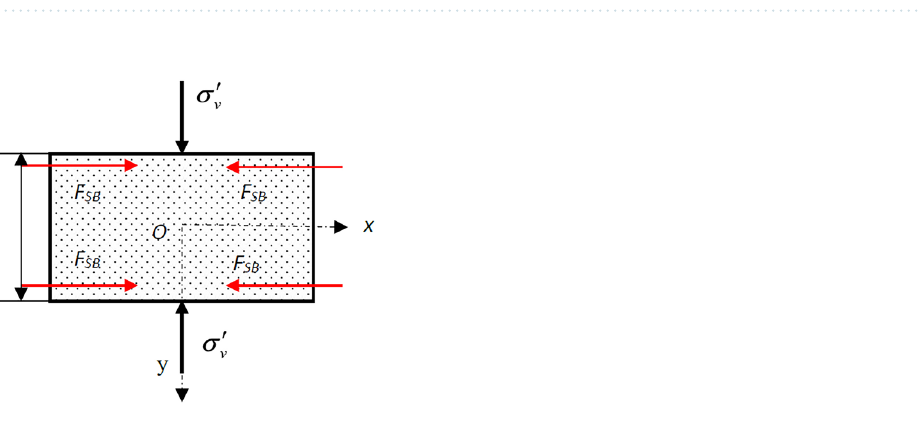
Figure 6. Mechanical model of the weak interlayer under uniaxial axis